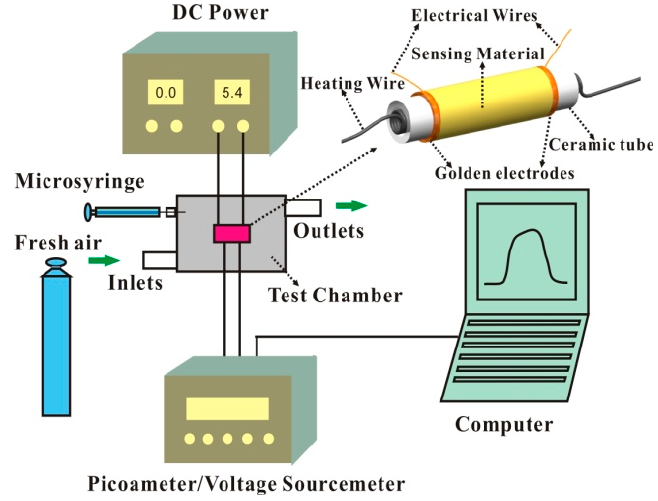
Figure 1. Schematic diagrams of the experimental system and the gas sensor.